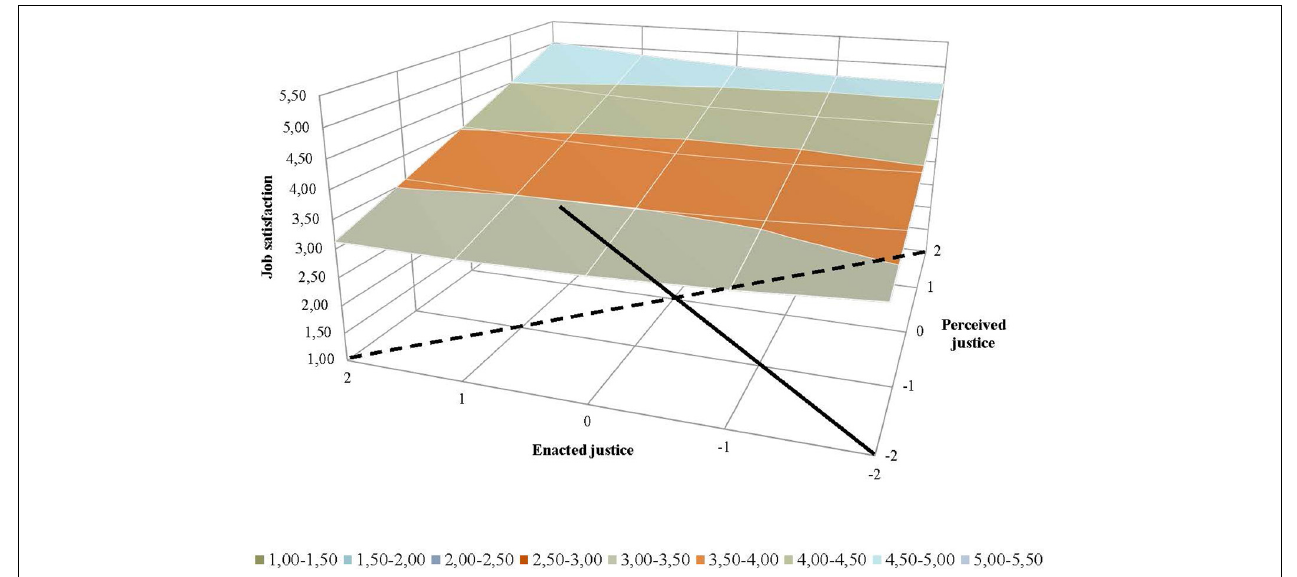
FIGURE 2 | Effects of (in)congruence between employees’ perceived pay justice and supervisors’ enacted pay justice on employees’ job satisfaction.